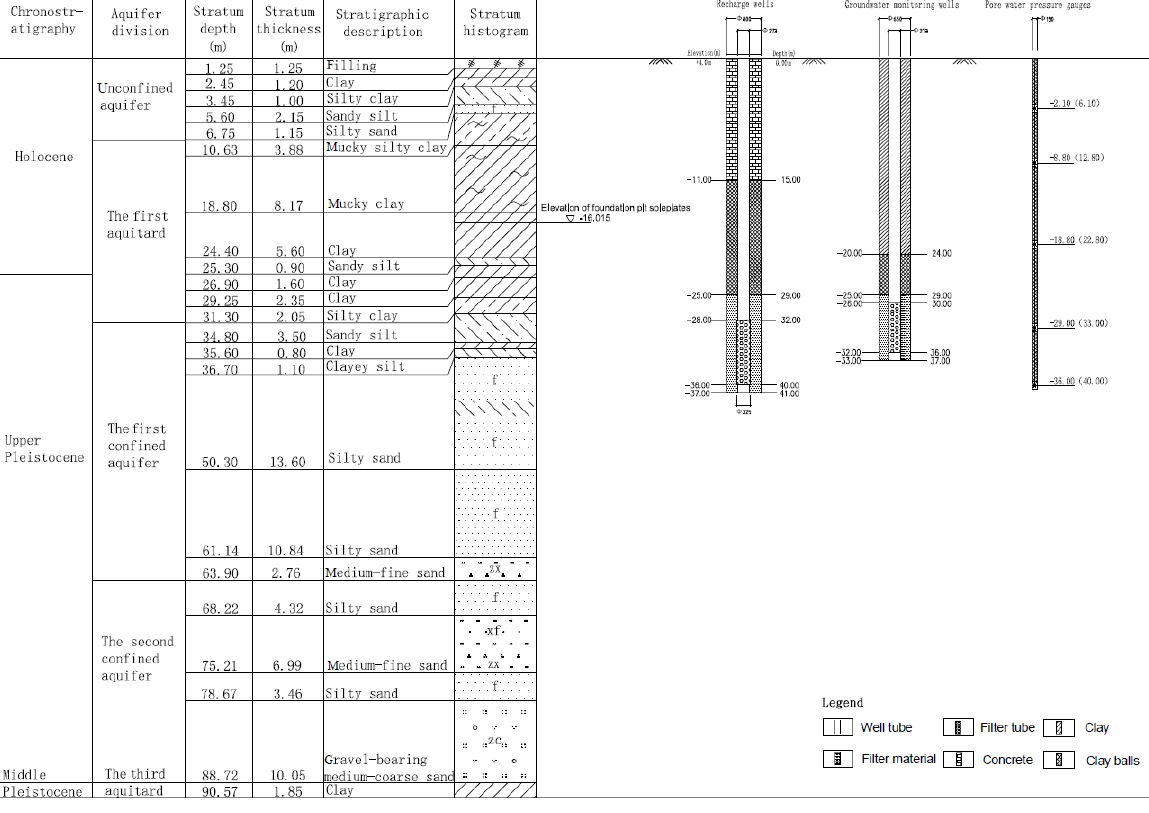
Figure 2. Engineering geological section of the foundation